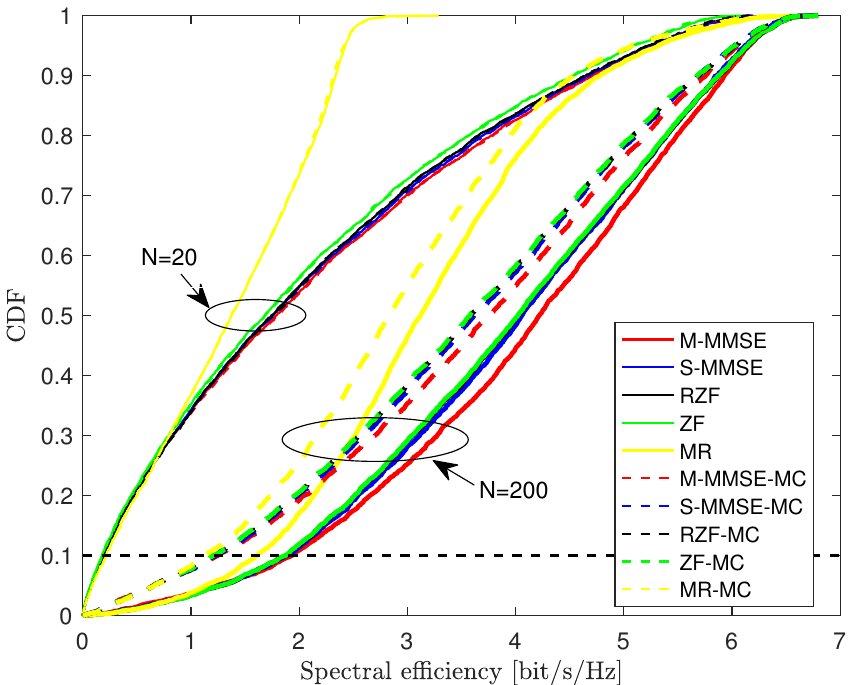
Figure 6. CDF of the spectral efficiency with and without mutual coupling when the antenna array size is